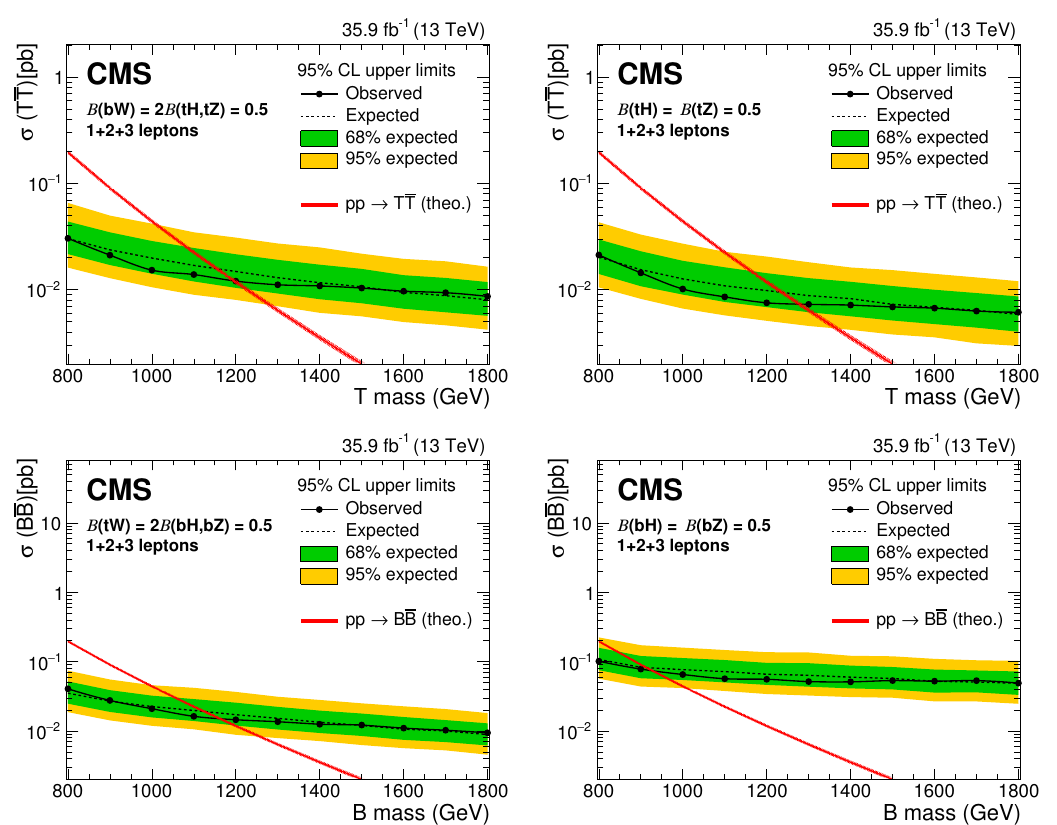
Figure 8 . The 95% CL expected and observed upper limits on the cross section of TT (upper row) and BB (lower row) production after combining all channels for the singlet (left) and doublet (right) branching fraction scenarios. The predicted cross sections are shown by the red curve, with the uncertainty indicated by the width of the